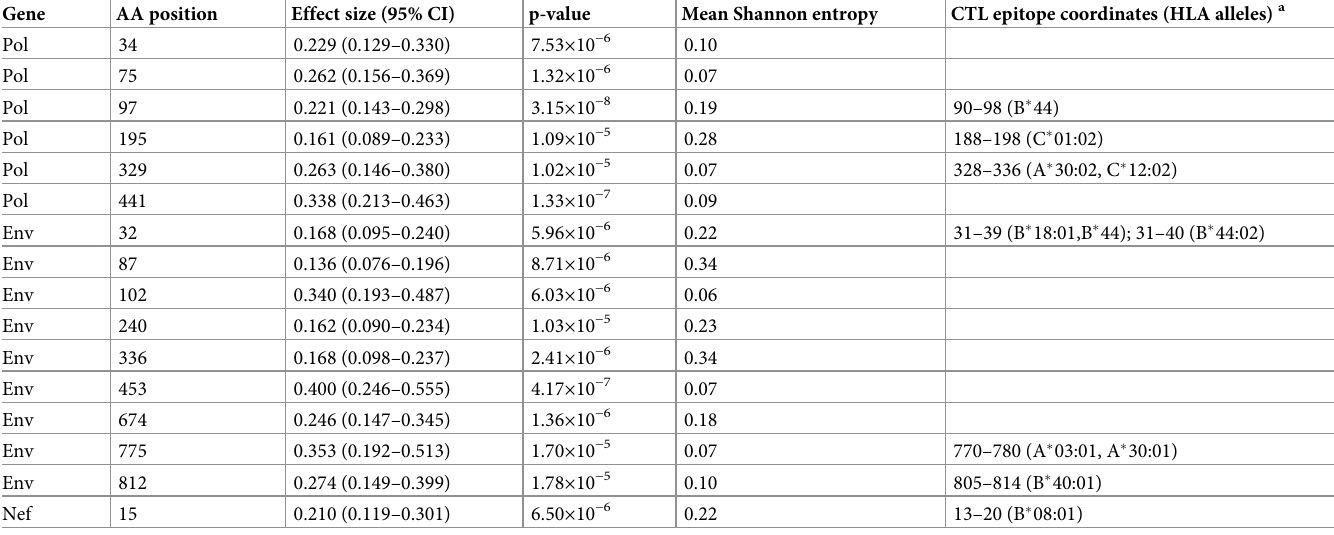
Table 1. Sixteen HIV amino acid (AA) positions where Shannon entropy was significantly associated with viral load